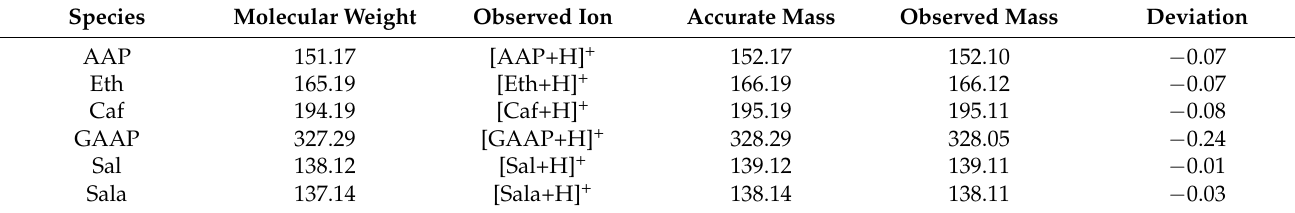
Table 2. Peaks shown in Figure 3 and the deviations from the accurate